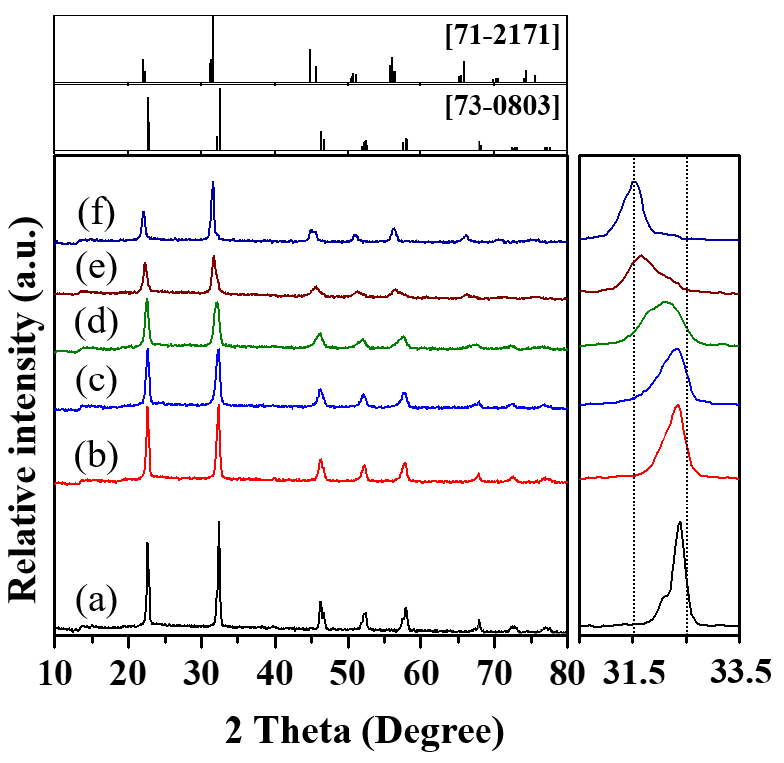
Figure 10. XRD patterns of KNN particles synthesized in glycothermal conditions with various molar ratios of K + /Na + at 200 °C for 12 h: ( a ) 1.0/1.0, ( b ) 1.4/0.6, ( c ) 1.5/0.5, ( d ) 1.6/0.4, ( e ) 1.7/0.3, and ( f ) 1.8/0.2. JCPDS database for KNbO 3 (JCPDS card 71-2171) and NaNbO 3 (JCPDS card 73-0803) are also included in the figure. Table 2. The lattice parameters of KNN particles synthesized by glycothermal treatment with various molar ratios of K + /Na + at 200 °C for 12 h.